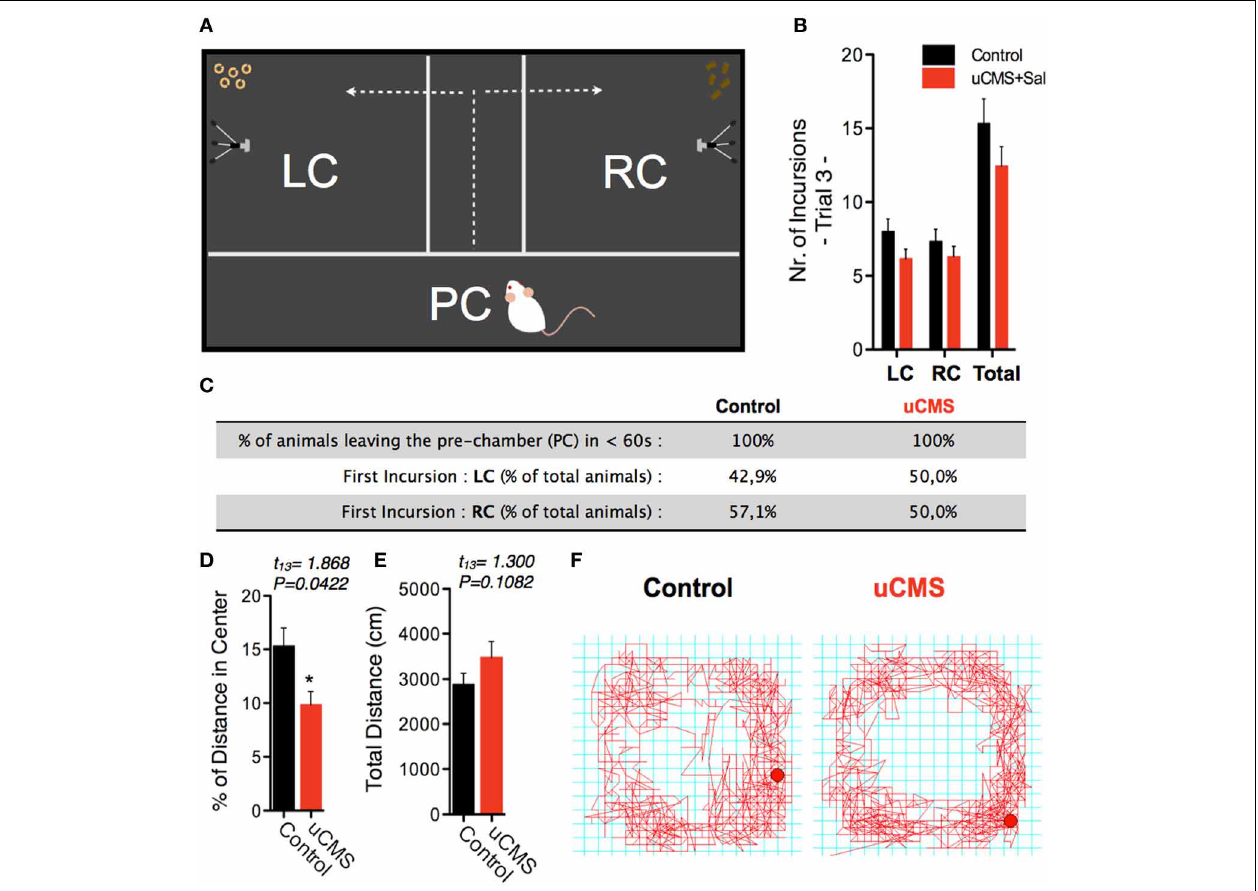
FIGURE 3 | Exploratory parameters in the SDT. (A,B) The average number of incursions into the left-chamber (LC; containing sweet pellets) and into the right-chamber (RC; containing regular pellets), during SDT was assessed and no significant differences were found. (C) Additional exploratory parameters were assessed in order to exclude a possible bias introduced by